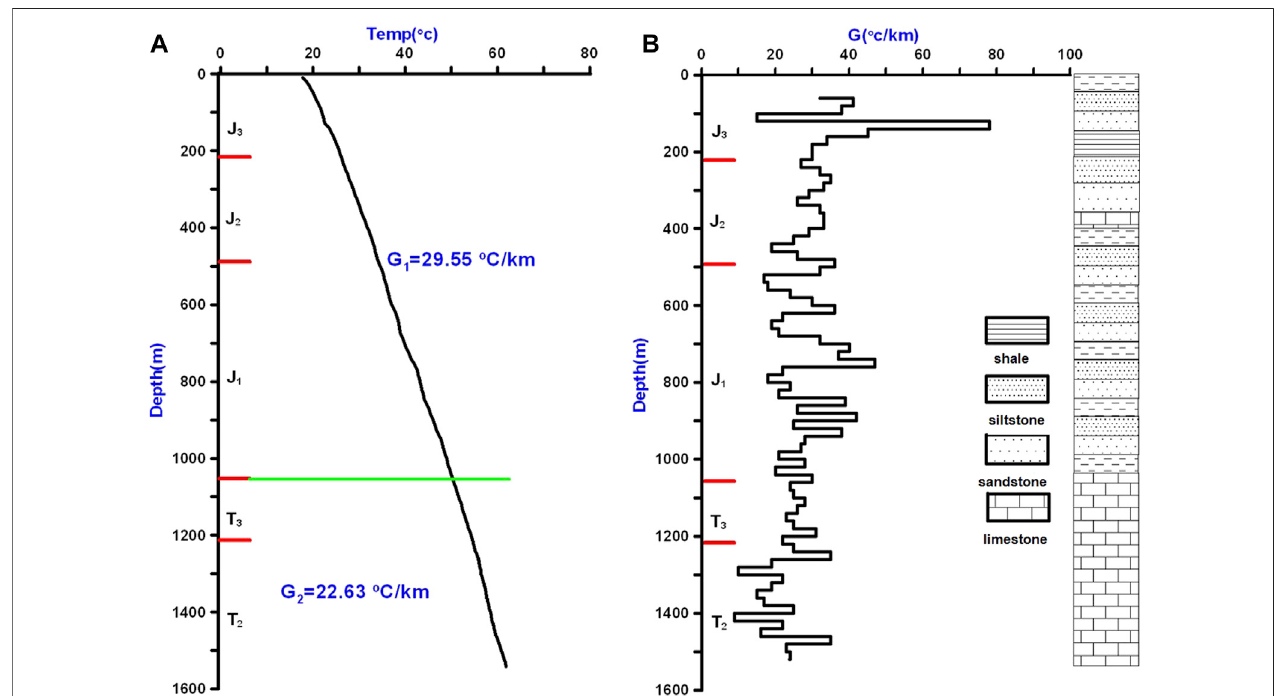
FIGURE 6 | Temperature logging curve (A) and the temperature gradient (B) of borehole C5.